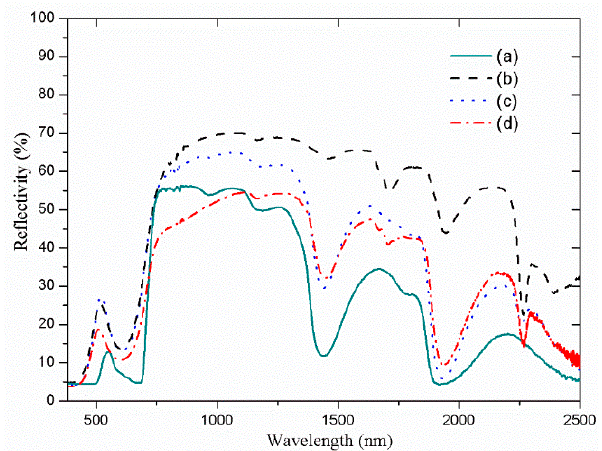
Figure 10. Solar spectral reflectance profiles of various materials: ( a ) Scindapsus aureus ; ( b ) bionic leaf A synthesized with PVDF and product M3; ( c ) bionic leaf B synthesized with PVDF, LiCl, and product M3; and ( d ) bionic leaf B after a simulated rain forest environmental condition for 48 h.